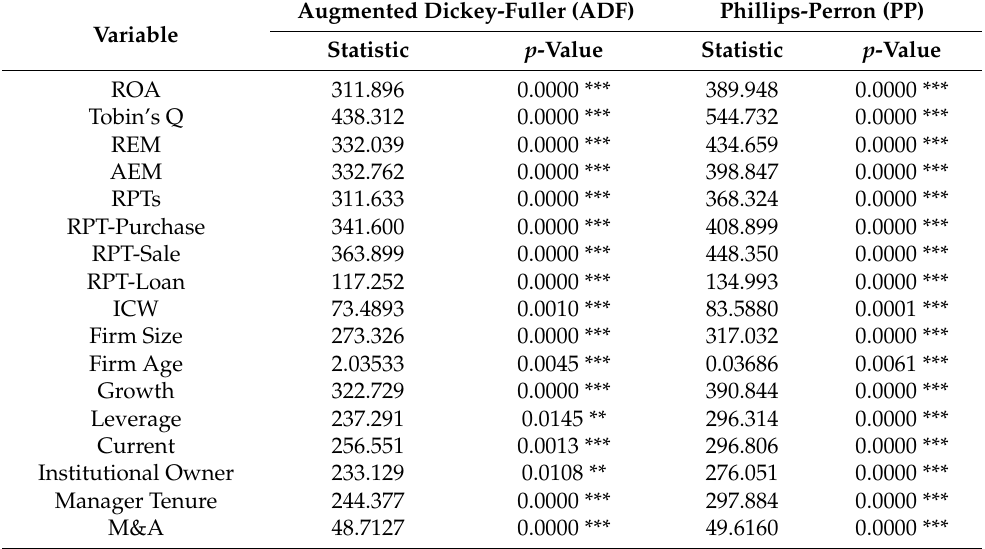
Table 5. The results of the unit root